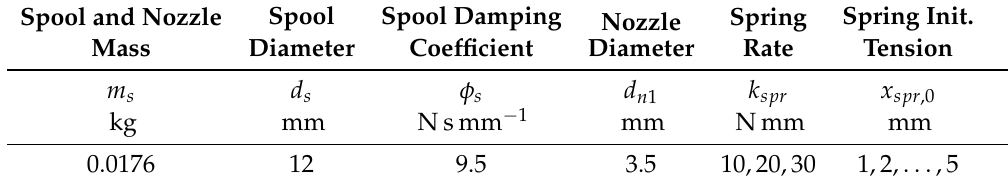
Table 4. Crucial valve parameters.